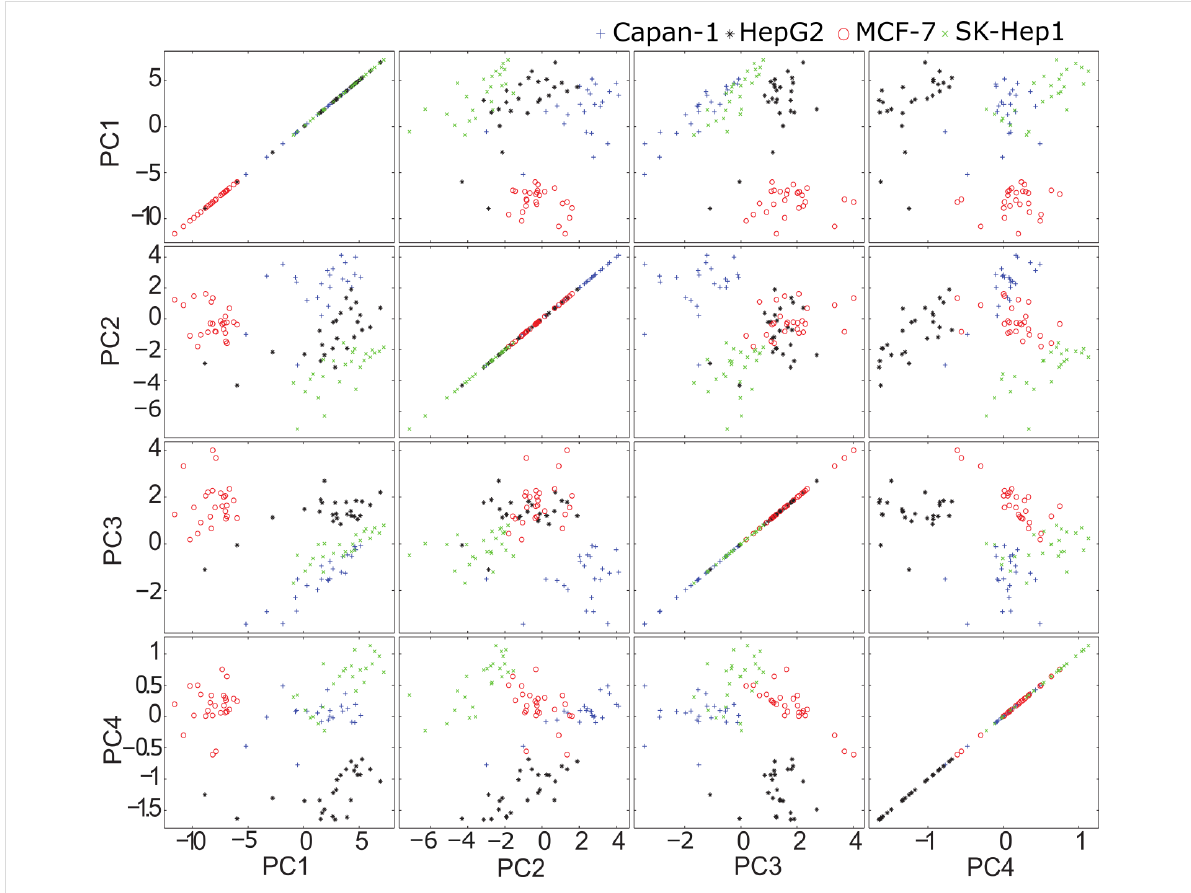
Figure 5: Score values of first four principal components of different cell lines. The four cell lines, MCF-7 (red circle), Capan-1 (blue plus sign), SK-Hep1 (green cross) and HepG2 (black star) are distinguished based on the first four PCs.